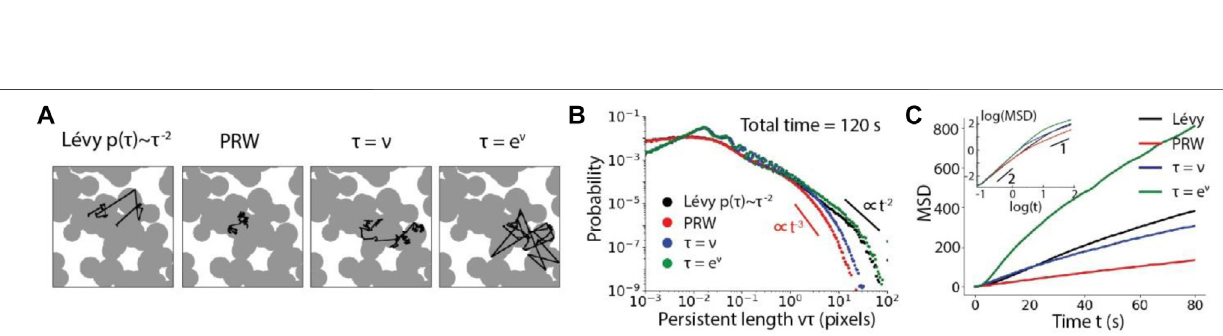
Frontiers in Physics |